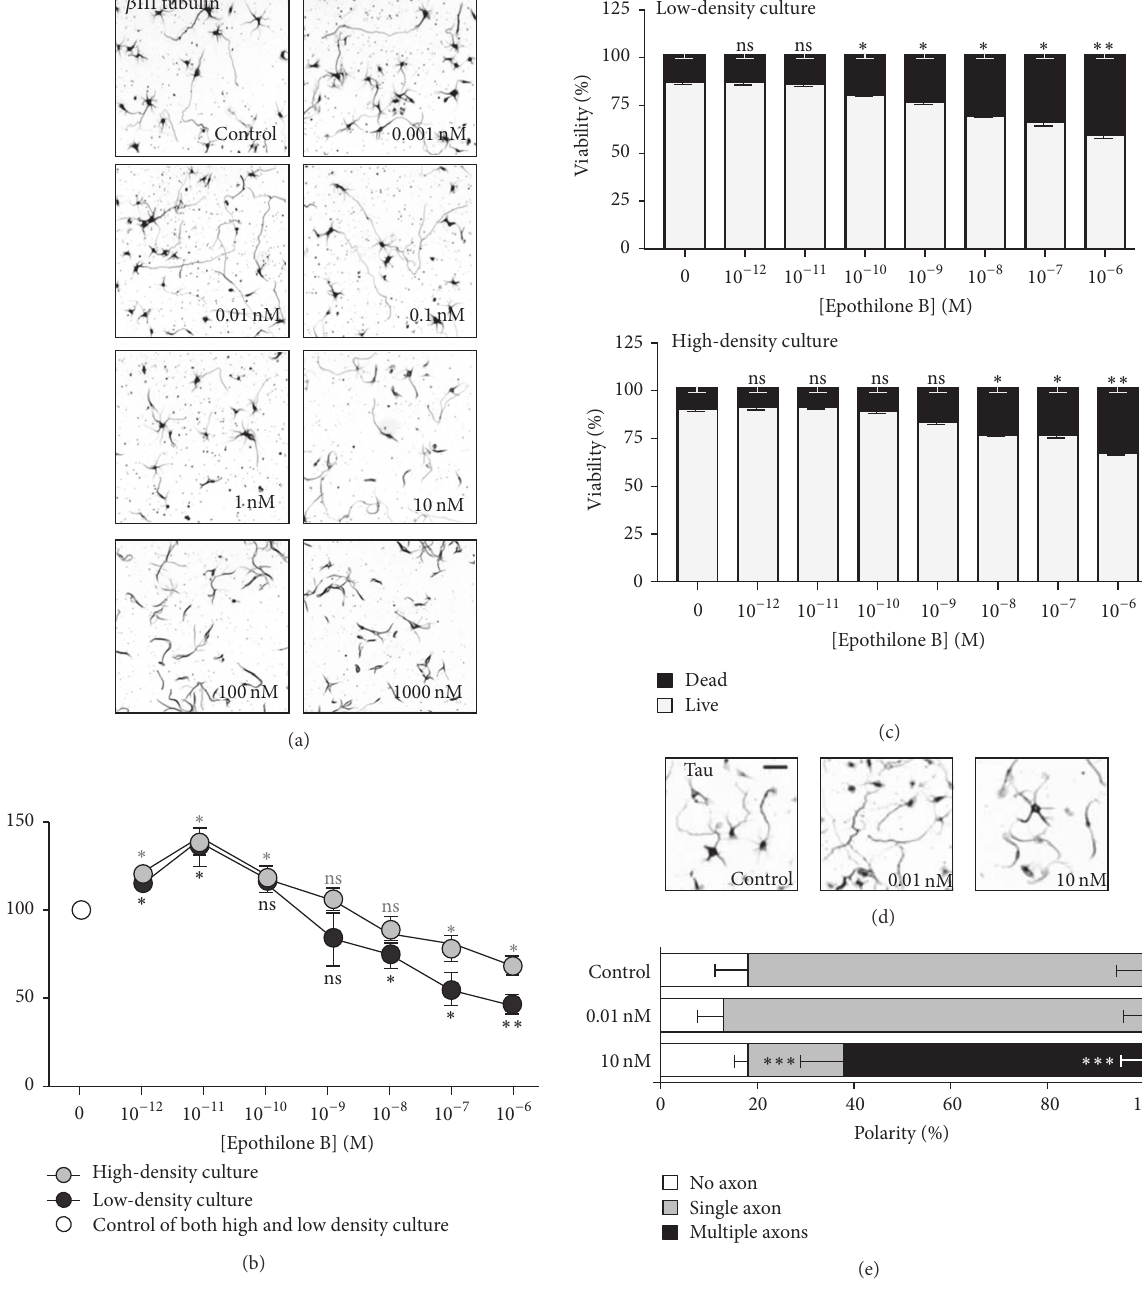
Figure 1: Effects of epothilone B on axon growth and cell viability in embryonic cortical neurons. (a–e) Embryonic day 15.5 (E15.5) cortical neurons were plated at a low density (5 × 10 4 cells/1.9 cm 2 ) or at high density (2 × 10 5 cells in 1.9 cm 2 ) and cultured in the absence or presence of various concentrations of epothilone B, from 1pM to 1 𝜇 M, as indicated. Low- and high-density cultures were fixed at 72 hr and 24 hr after plating, respectively, and subjected to immunostaining with anti-Tuj1 antibodies (a, b). Representative images ((a), inverted images from Tuj1 immunostaining; low-density culture) and quantification of axon length (b) are shown (gray, high-density culture and black, low-density culture). Cell viability was assayed by propidium iodide (PI) staining (c). To assess polarization, neurons treated with vehicle (control) or the indicated concentration (0.01 nM or 10 nM) of epothilone B were immunostained with anti-Tau antibodies (d, e). Representative images (d) and quantification of neuronal polarity (e) are shown. Scale bar, 50 𝜇 m. ∗ 𝑝 < 0.05, ∗∗ 𝑝 < 0.01, and ∗∗∗ 𝑝 < 0.001; ns, statistically not